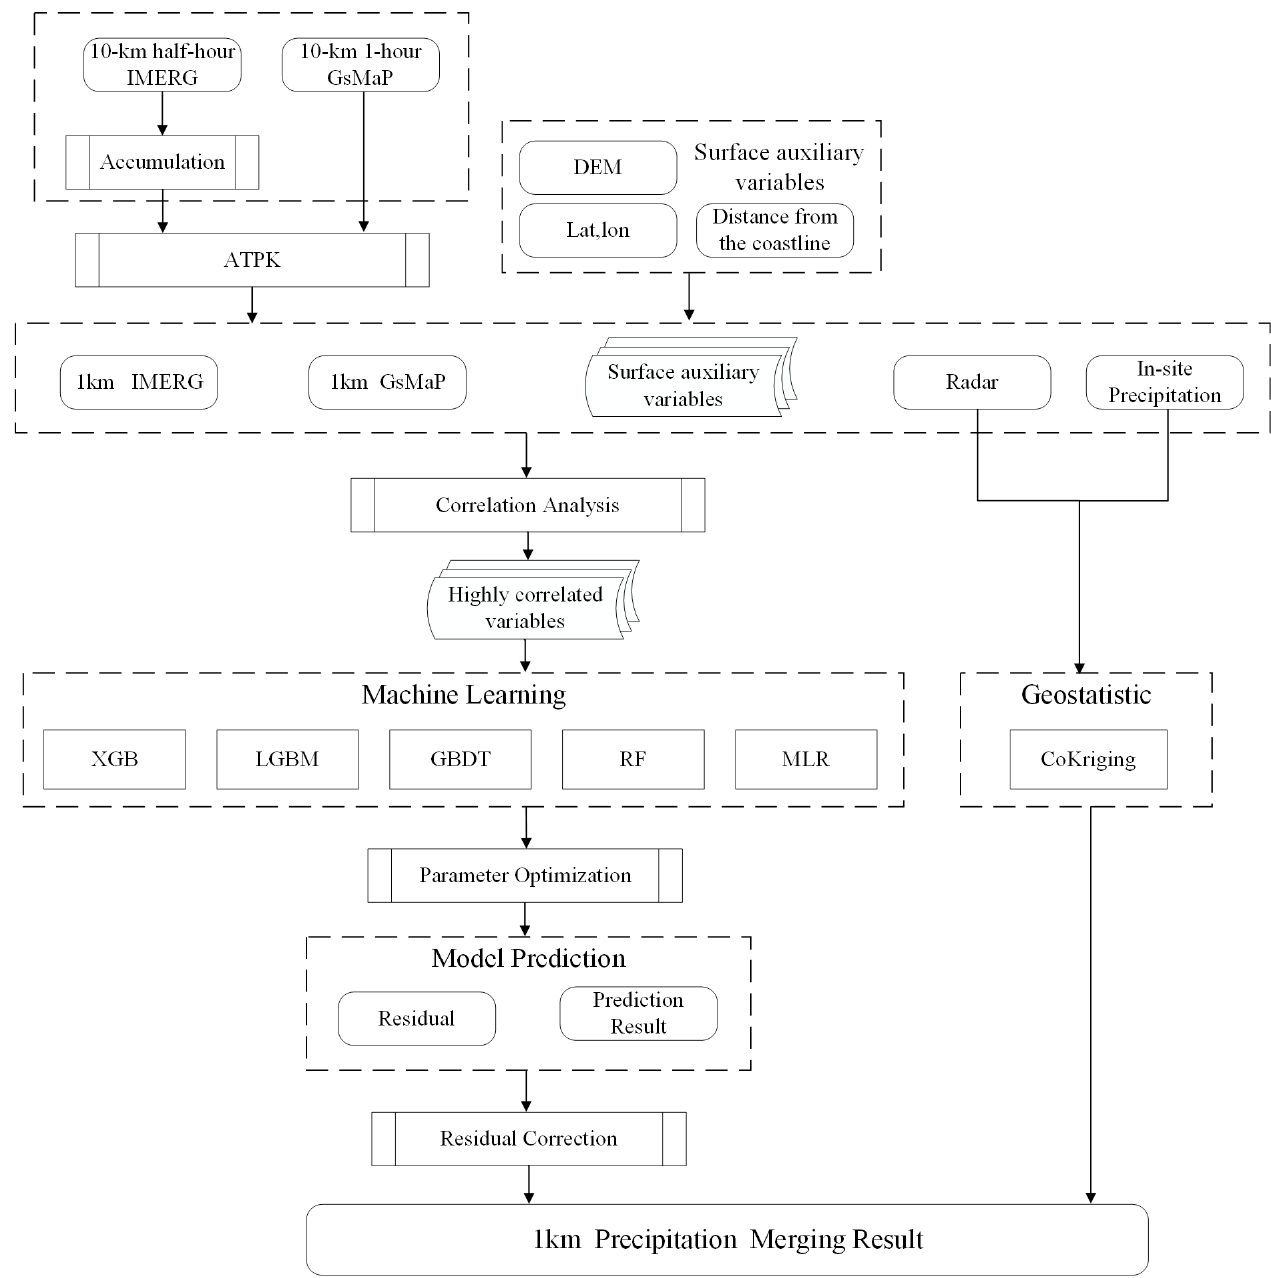
Figure 2. Flow chart of multi-source precipitation data merging.